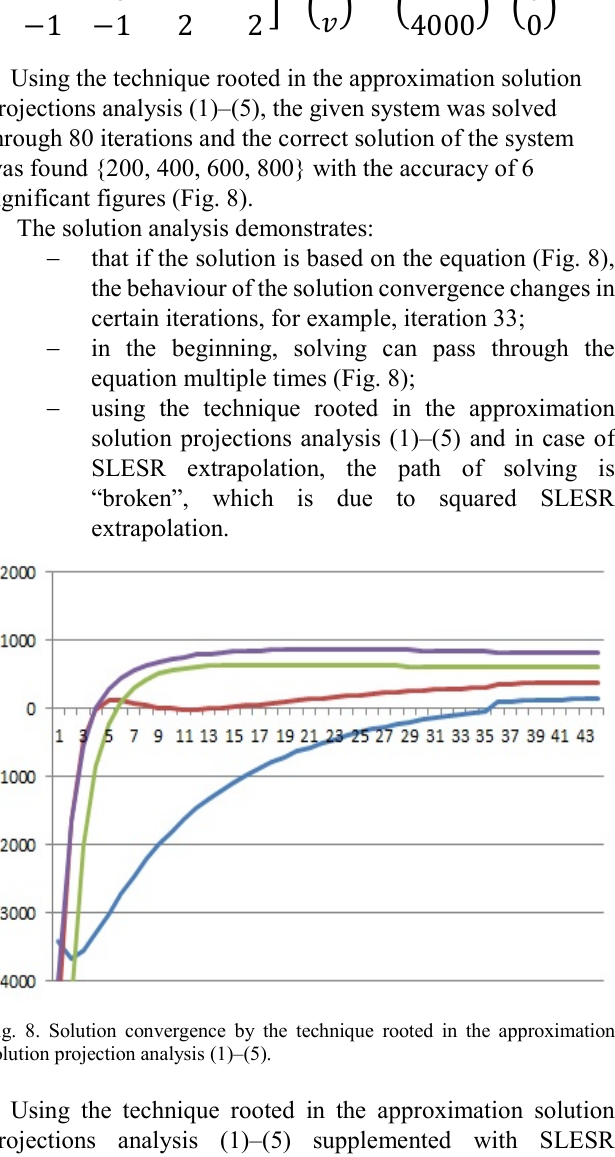
Fig. 10. 20 first iterations of the solution process, convergence in the projection onto the xy